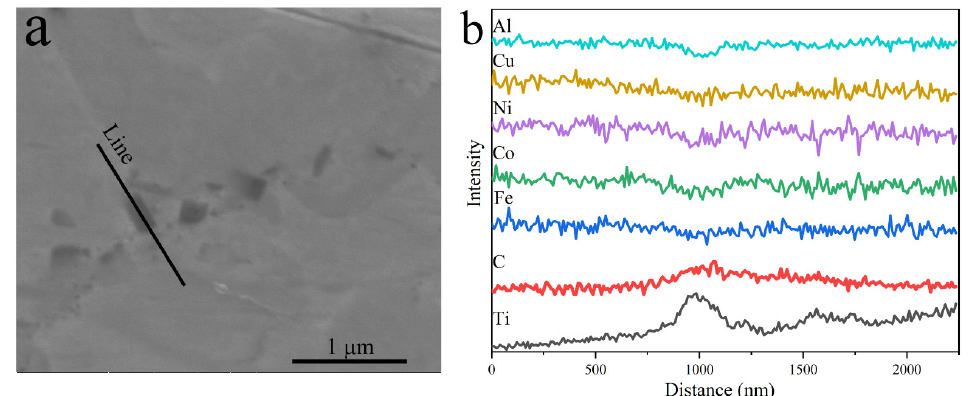
Figure 4. ( a ) SEM image showing the position of the line scan and ( b ) compositional profiles of the Ti- and C-rich carbide in the HEA-10TiC composite. Table 2. Chemical compositions of the FCC phase, BCC phase, and TiC phase.